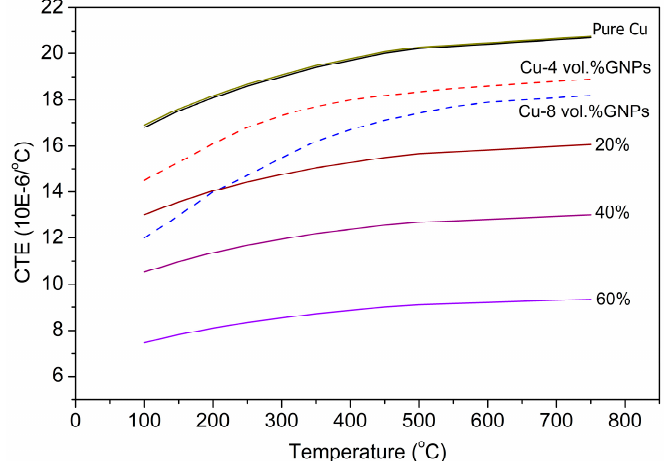
Figure 7. The theoretical predictions and experimental coefficient of thermal expansion of pure